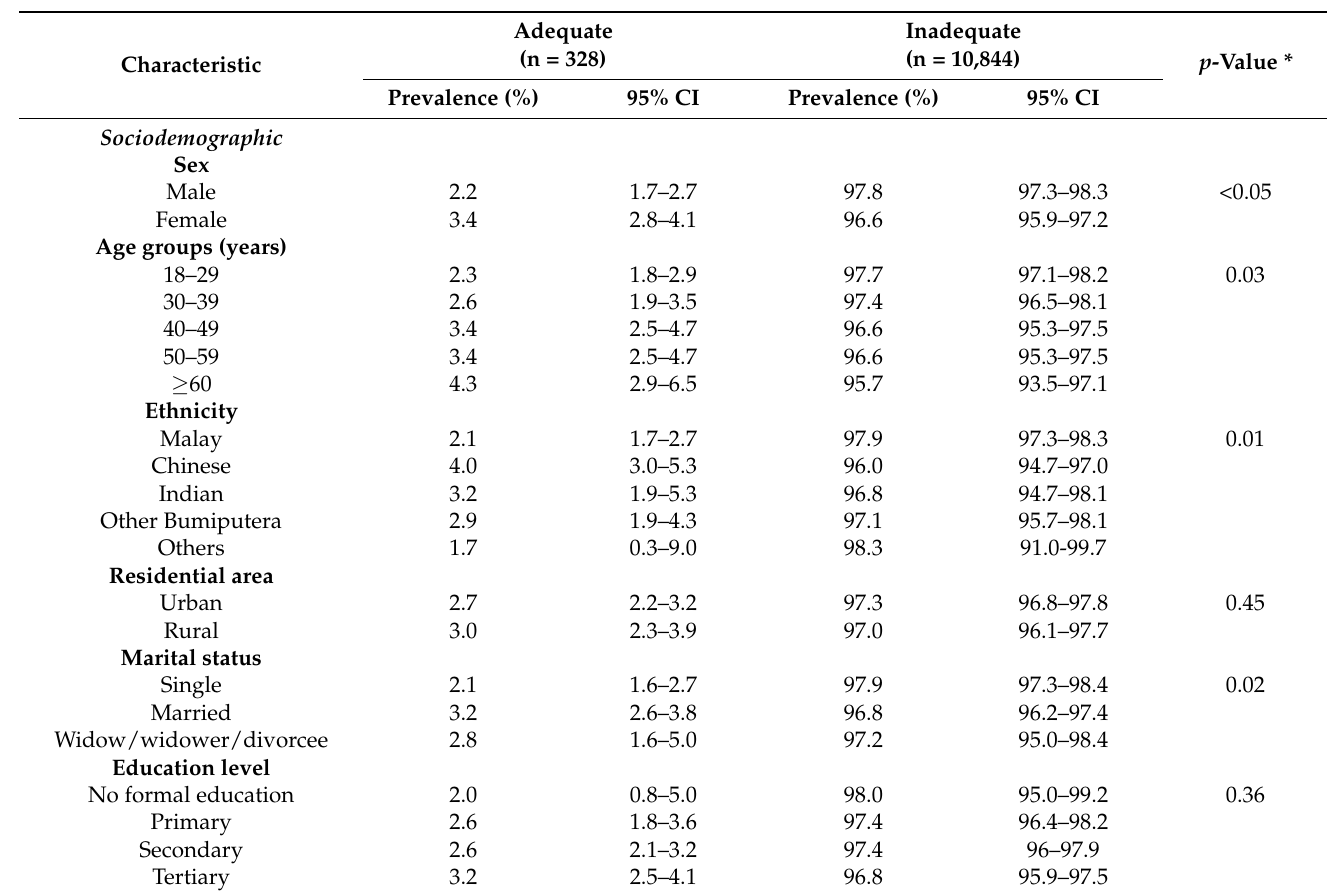
Table 2. Characteristics of the adult respondents aged 18 years and above, by adequacy of fruit and vegetable intake, (n =